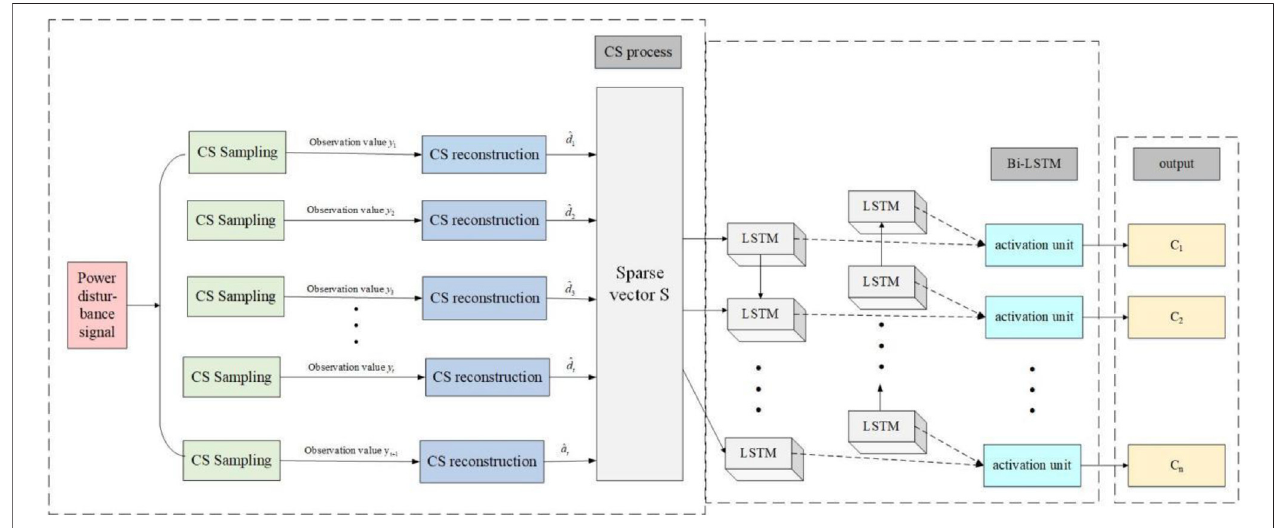
FIGURE 4 | Structure of